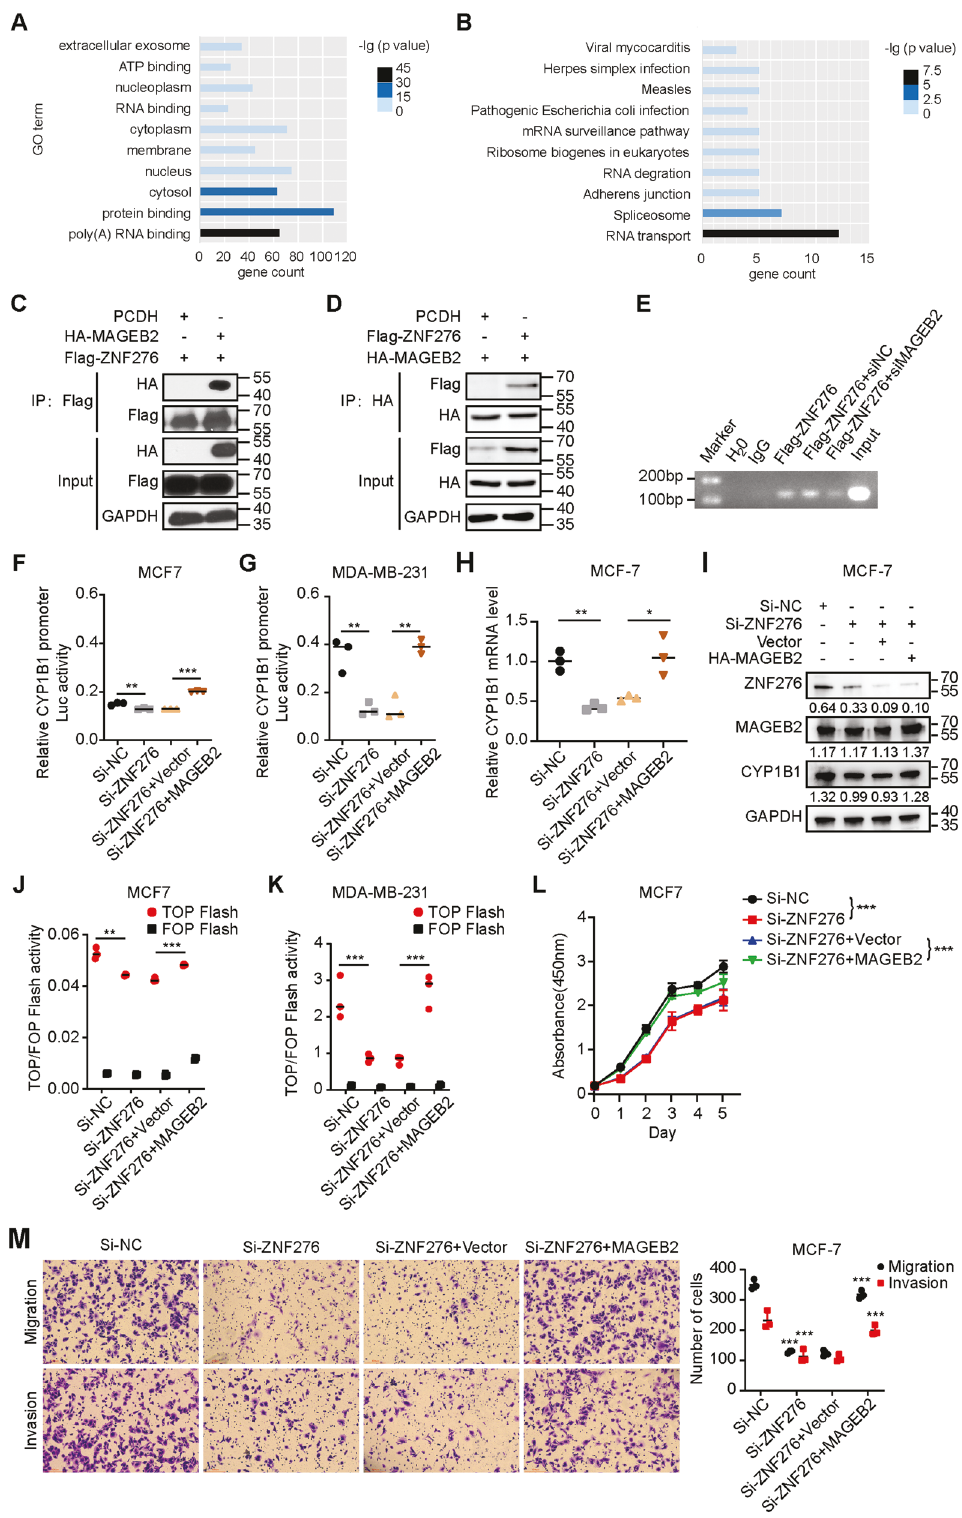
Fig. 7 ZNF276 activates Wnt/ β -catenin signaling through recruitment of MAGEB2 to regulate CYP1B1 transcription. A GO analysis of the potential ZNF276-interacted proteins. B KEGG analysis of the potential ZNF276-interacted proteins. C , D Both forward ( C ) and reverse ( D ) co-IP analysis af fi rmed the interaction between ZNF276 and MAGEB2. E ChIP-PCR analysis of ZNF276 binding ability at the CYP1B1 promoter affected by MAGEB2 overexpression. F , G The luciferase activity of CYP1B1 promoter decreased by ZNF276 silencing was further enhanced by the expression of MAGEB2 in 293T and MCF-7. H , I RT-qPCR ( H ) and western blot ( I ) analysis con fi rmed the effect of MAGEB2 overexpression in CYP1B1 mRNA and protein expression in MCF-7 cells. J , K The reduced transcriptional activity of CYP1B1 promoter by ZNF276 was partially reversed by MAGEB2. L , M Overexpression of MAGEB2 reversed the decreased cell proliferation, migration and invasion abilities affected by ZNF276 silencing in CCK-8 assay ( L ), transwell migration ( M , up) and transwell invasion ( M , down). Cell Death and Disease (2022)